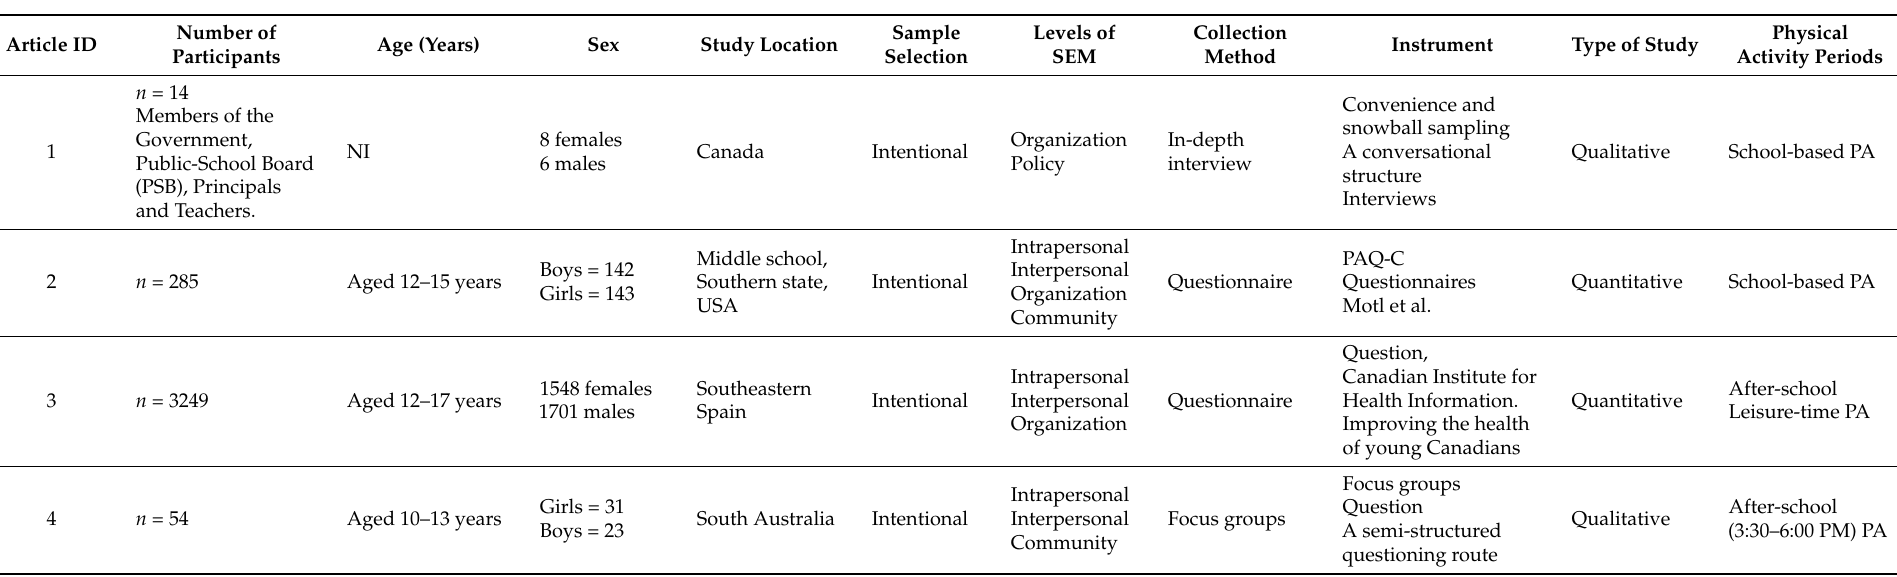
Table 2. Summary of included qualitative and quantitative studies reporting the factors that influence participation in physical activity in children and